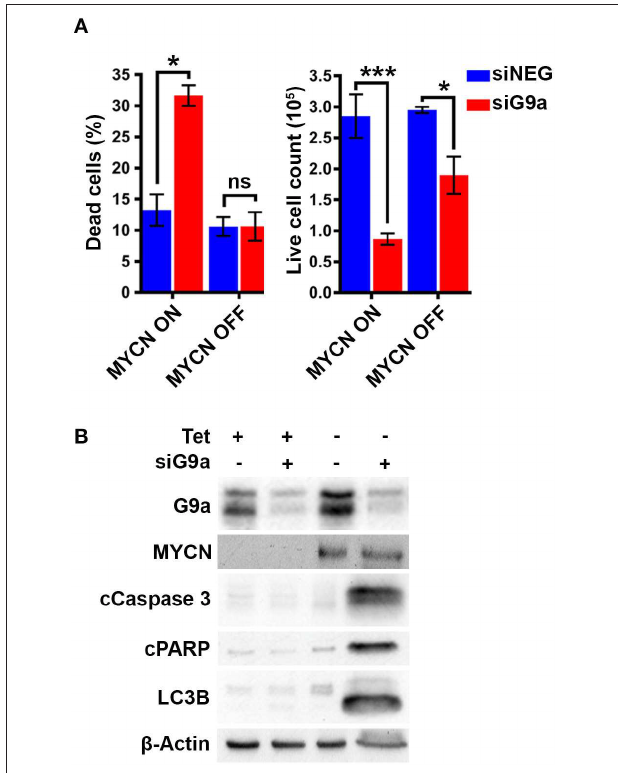
FIGURE 4 | G9a depletion leads to cell death in MYCN induced S21N cells only. (A) Floating and adherent cells from S21N cells, with and without MYCN induction, were harvested and counted by trypan blue inclusion assay following G9a depletion as previously. (B) Immunoblot of G9a and apoptosis and autophagy markers. (* p < 0.05, *** p < 0.01, ns, not significant, n =